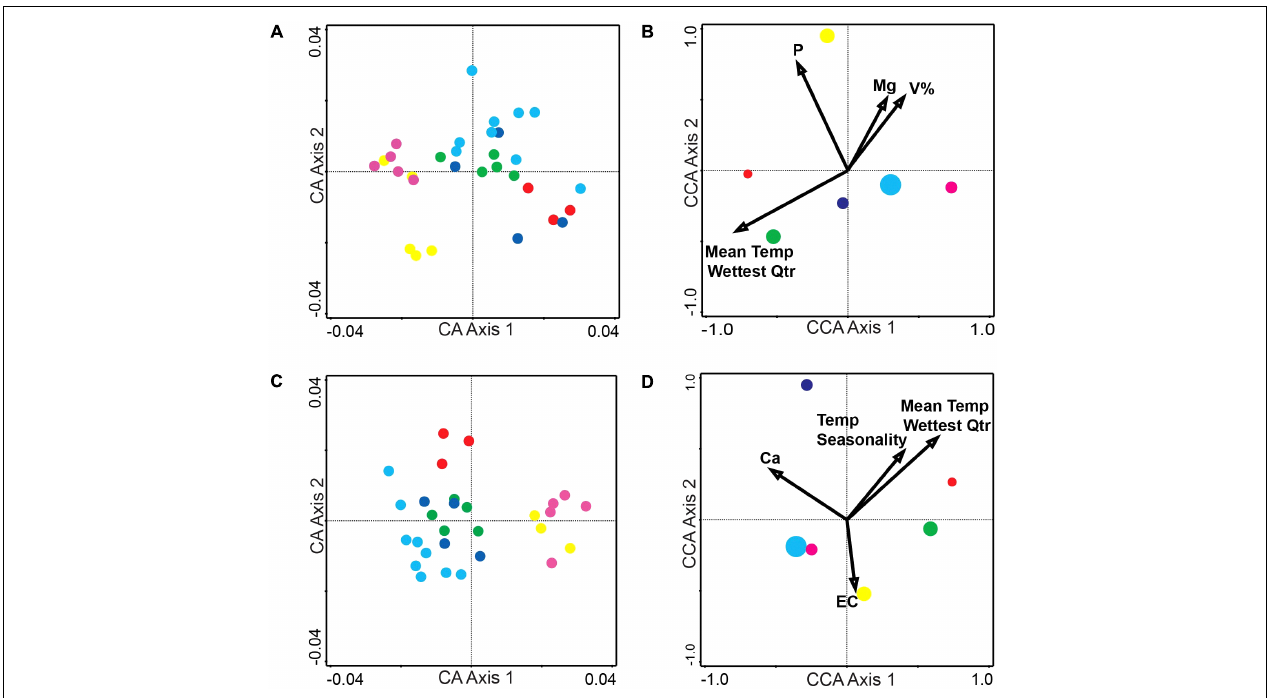
FIGURE 1 | Correspondence Analysis (CA) and Canonical Correspondence Analysis (CCA) for the alkaloid and phenolic extractions. (A) CA ordination plot of alkaloid extraction at the six sites with each dot representing an individual plant (average of three biological replicates) at a site (B) CCA ordination biplot of alkaloid extractions displaying environmental variables (arrows) and each site (circle with size representing the number of individuals collected) (C) CA ordination plot of phenolic extraction at the six sites with each dot representing an individual plant (average of three biological replicates) at a site (D) CCA ordination biplot of phenolic extraction displaying environmental variables (arrows) and each site (circle with size representing the number of individuals collected). Number of individuals collected and site location (A–F) is also noted in Table 1 . Numerical results of CA and CCA are in Table 2 . Site A is Red, Site B is Green, Site C is Dark Blue, Site D is Light Blue, Site E is Magenta, and Site F is Yellow.